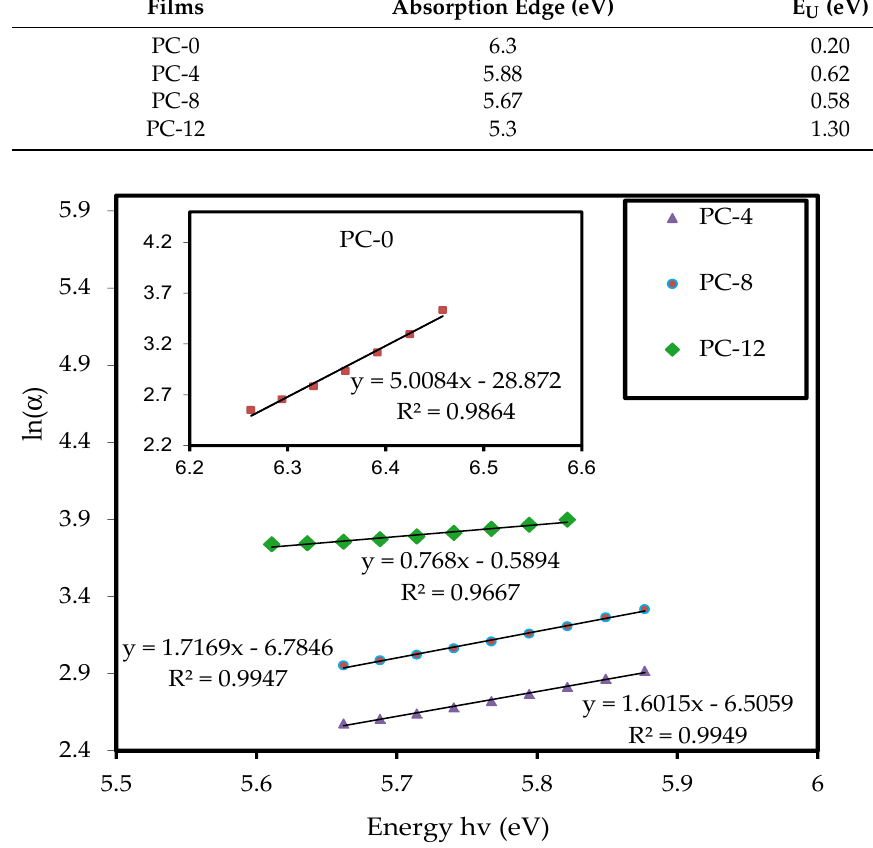
Figure 6. Urbach plot for pure PVA and PVA/PbS NCPs.